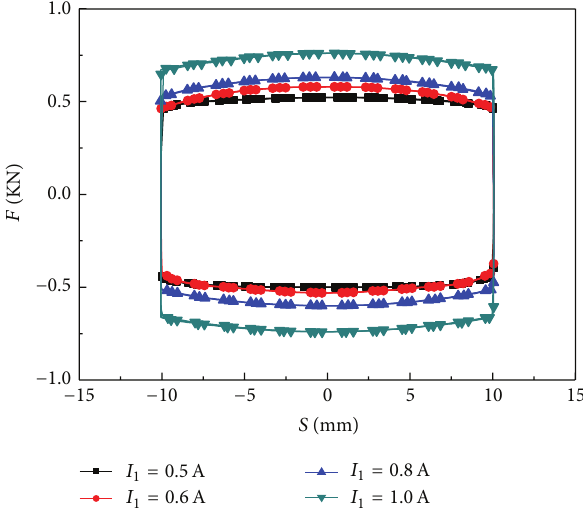
Figure21:Dampingforceunderdifferentcurrentsinthedoublecoil ( 𝐼 2 = 0.5